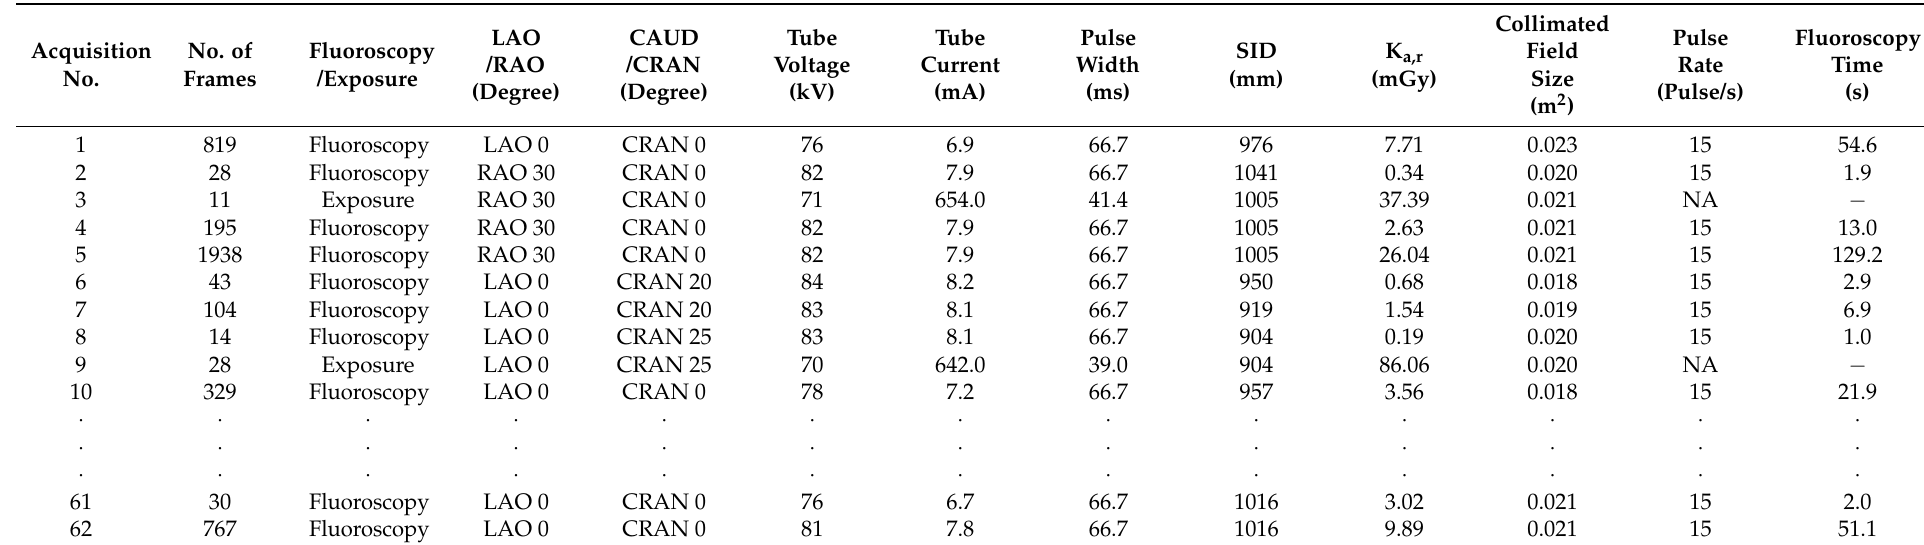
Table 1. Example of a DICOM—Radiation Dose Structured Report (DICOM-RDSR) at our